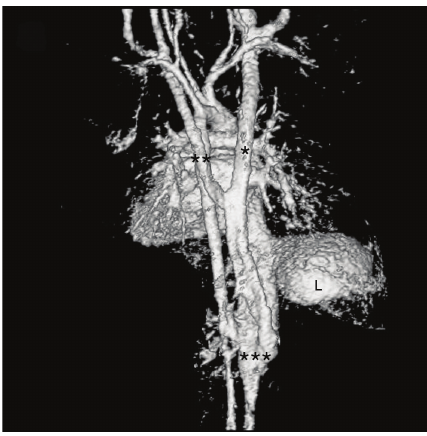
Figure 3: 3D MRA construction of bilateral SVC absence from a posterior view showing the aorta and venous structures around the diaphragm. ∗ Right azygos vein. ∗∗ Left hemiazygos vein. ∗∗∗ Fused azygos and hemiazygos veins joining the IVC. Liver